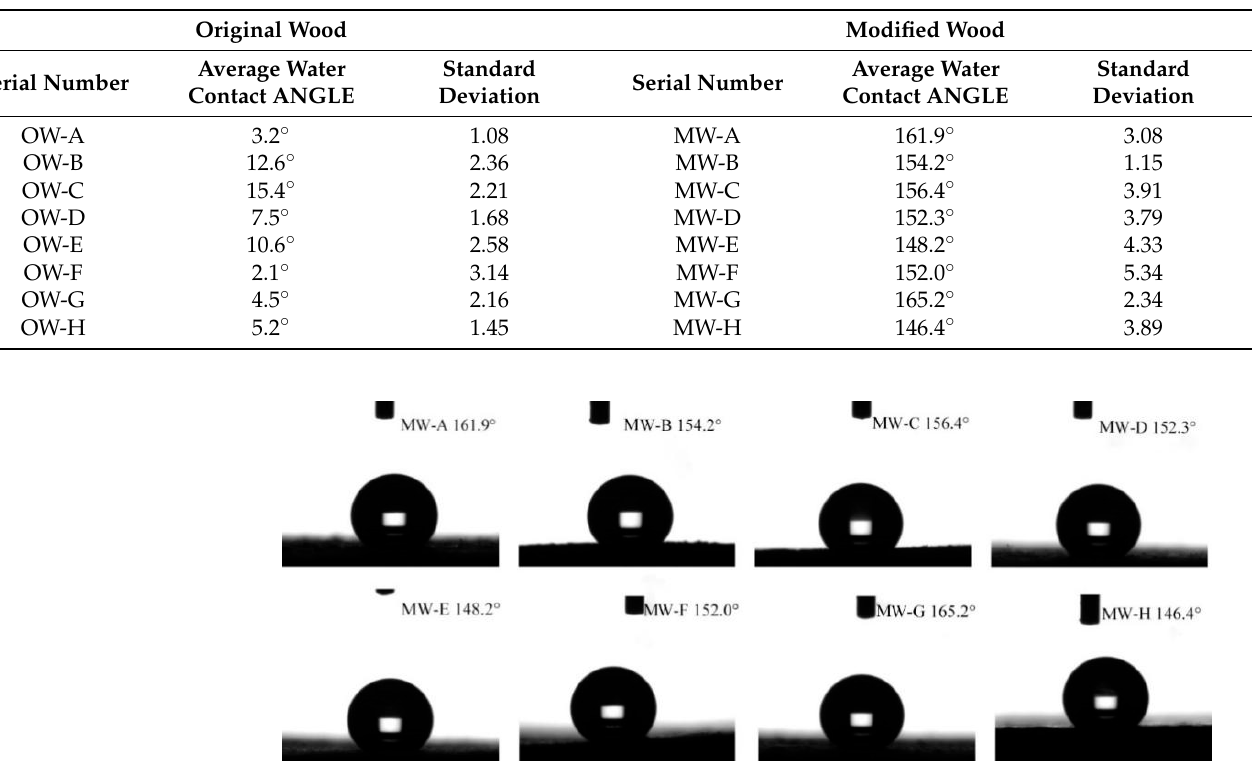
Table 3. Wood average water contact angle and standard deviation before and after modification.